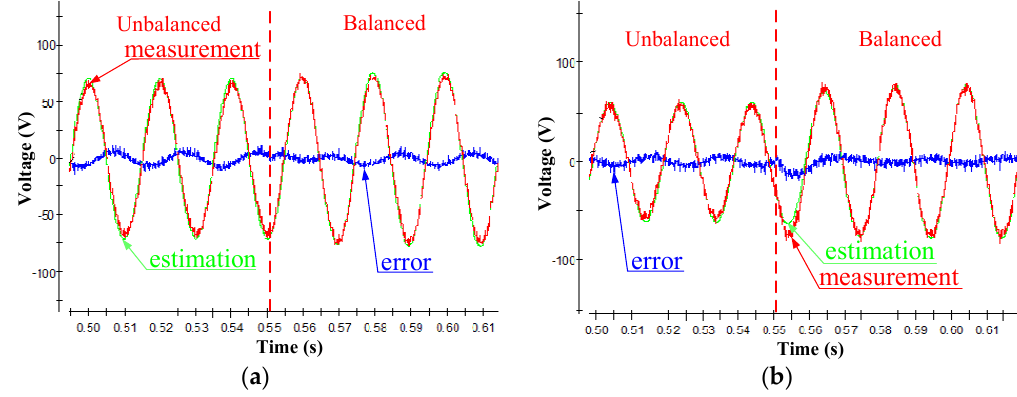
Figure 10. Experimental comparisons between measurements and estimations for the grid voltage in the αβ reference system when grid voltage varies from unbalanced to balanced in case 1: ( a ) Grid voltage in α -axis, ( b ) grid voltage in β